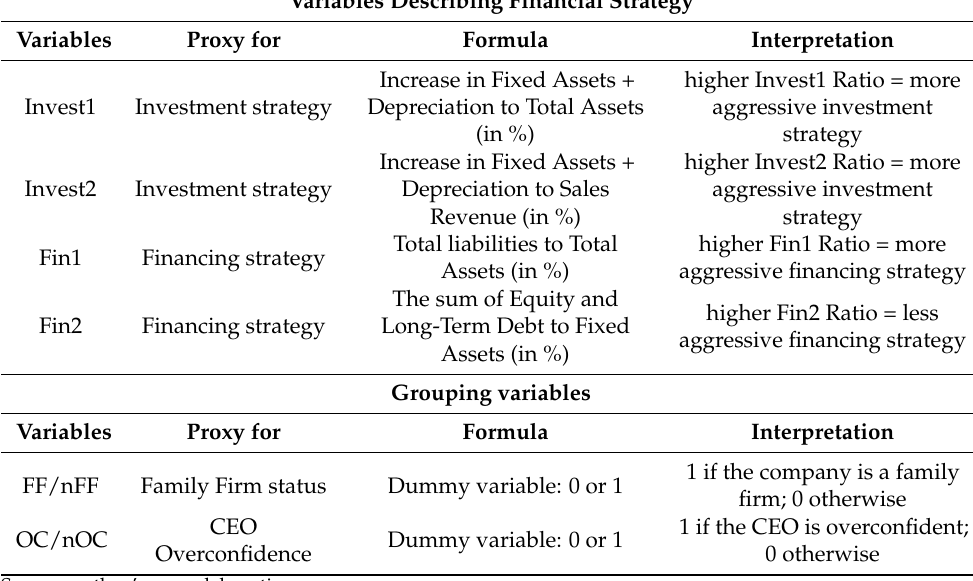
Table 1. Description of the variables used in research. Variables Describing Financial